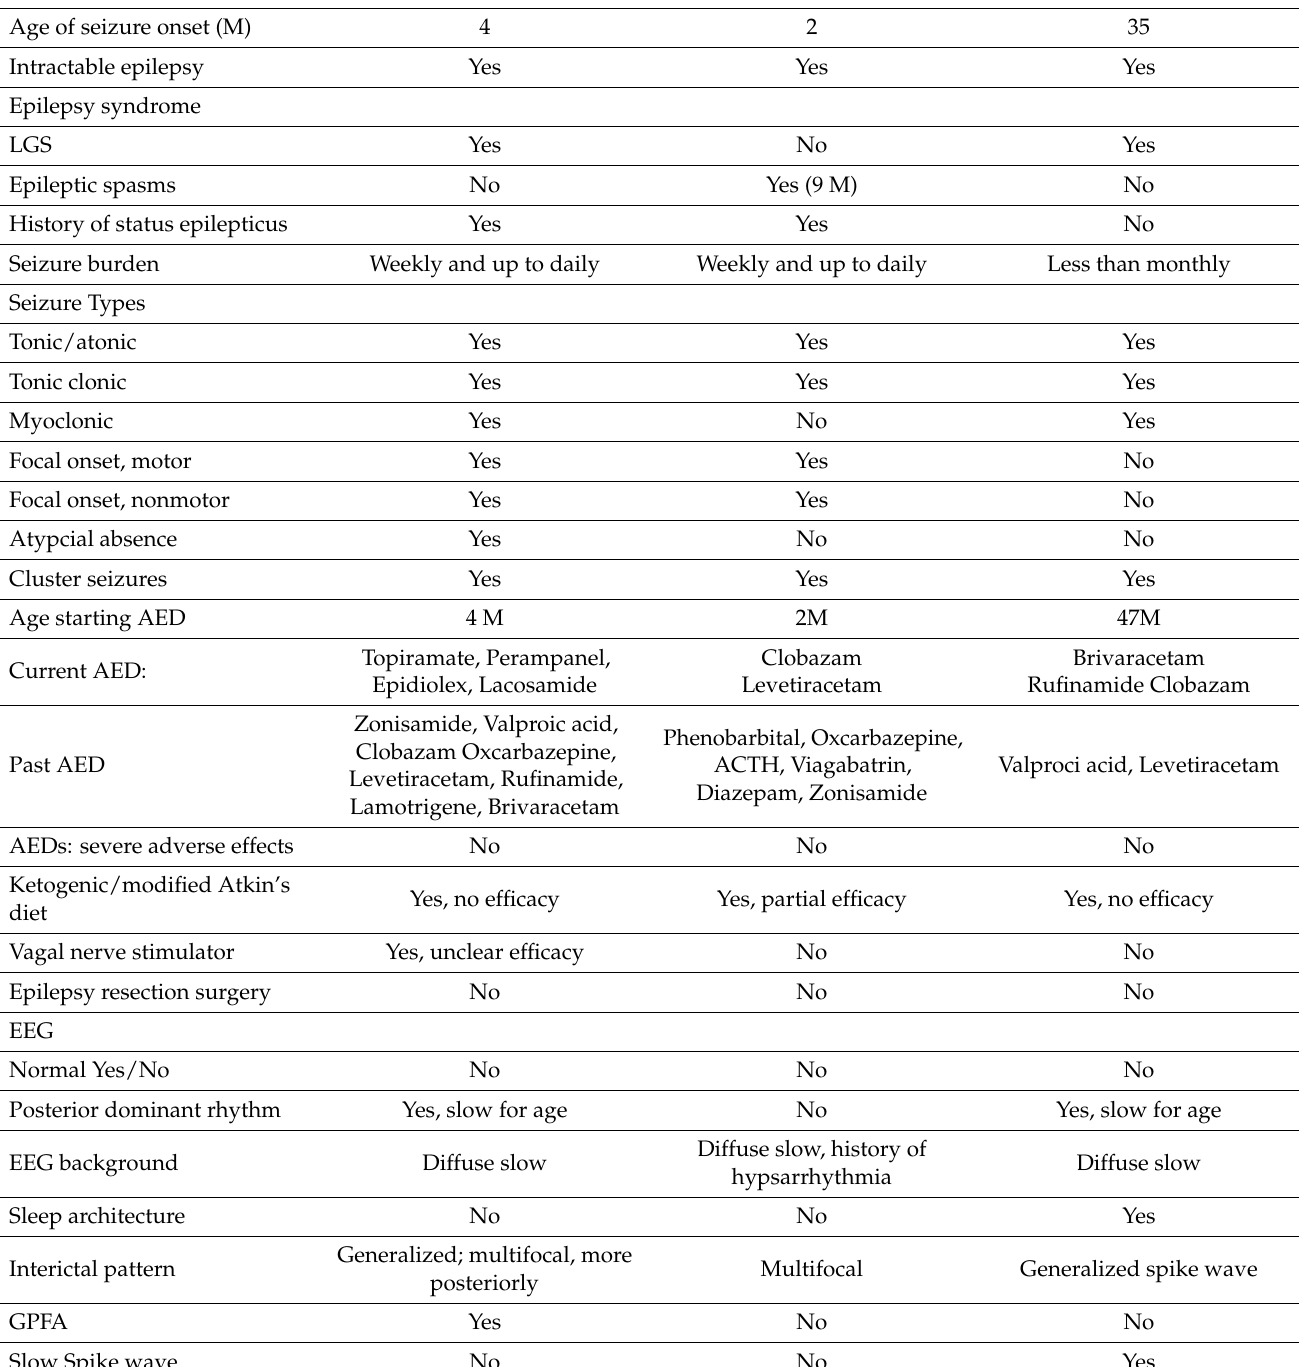
Table 2. Patients’ characteristics in